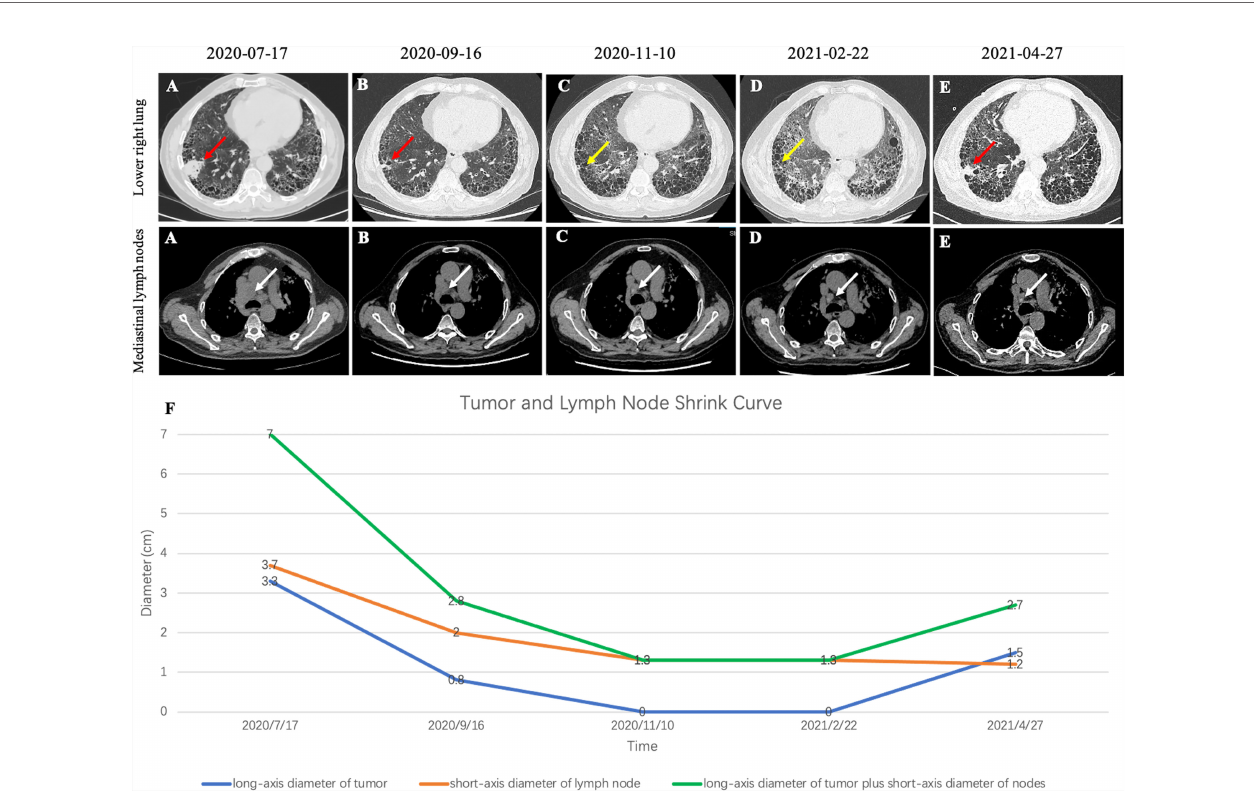
FIGURE 3 | (A) CT image before crizotinib treatment. (B) CT image at 1 month after crizotinib treatment beginning. (C) CT image at 3 months after start of crizotinib treatment. (D) CT image at 3 months after discontinuing treatment. (E) CT image at 5 months after discontinuing treatment. (F) Tumor and lymph node shrink curve. Note that red arrows indicate the tumor. Yellow arrows indicate that the primary tumors almost disappeared. White arrows indicate the lymph nodes.